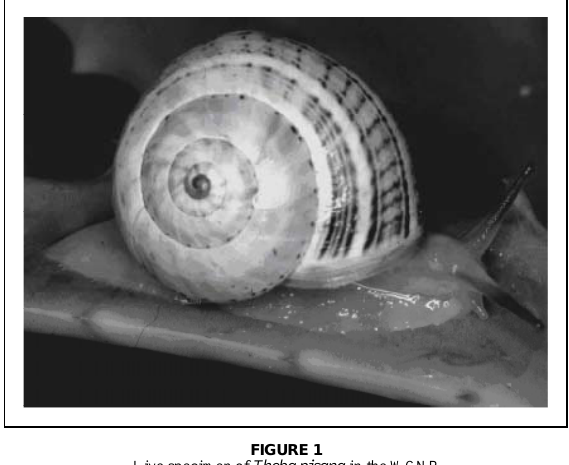
Figure 1 Live specimen of Theba pisana in the WCNP